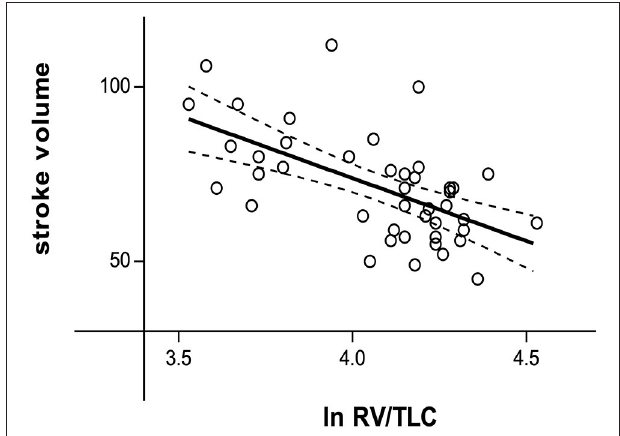
FIGURE 1 | Relationship between the natural logarithm of RV/TLC and stroke volume during resting conditions ( r = − 0.585, P < 0.001). ln RV/TLC, natural logarithm of residual volume/total lung capacity.